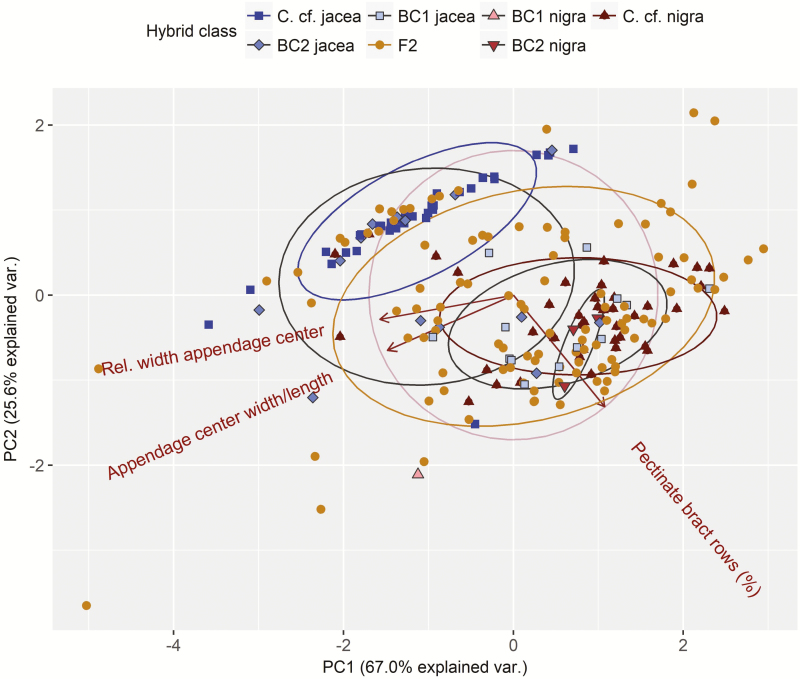
Principal component analysis based on three morphometric capitula traits [seeSupporting Information—Table S1.3; Fig. S1.1] derived from diagnostic characteristics from previous morphometric analyses on European samples of the C. jacea/nigra complex (Hardy et al. 2000; Vanderhoeven et al. 2002). The traits were measured for 133 individuals using standardized digital images of one or two field-collected capitula per individual. Coloured labels correspond to hybrid classes derived from the NewHybrids analysis using the C. cf. nigra marker panel (Fig. 2B, upper panel).